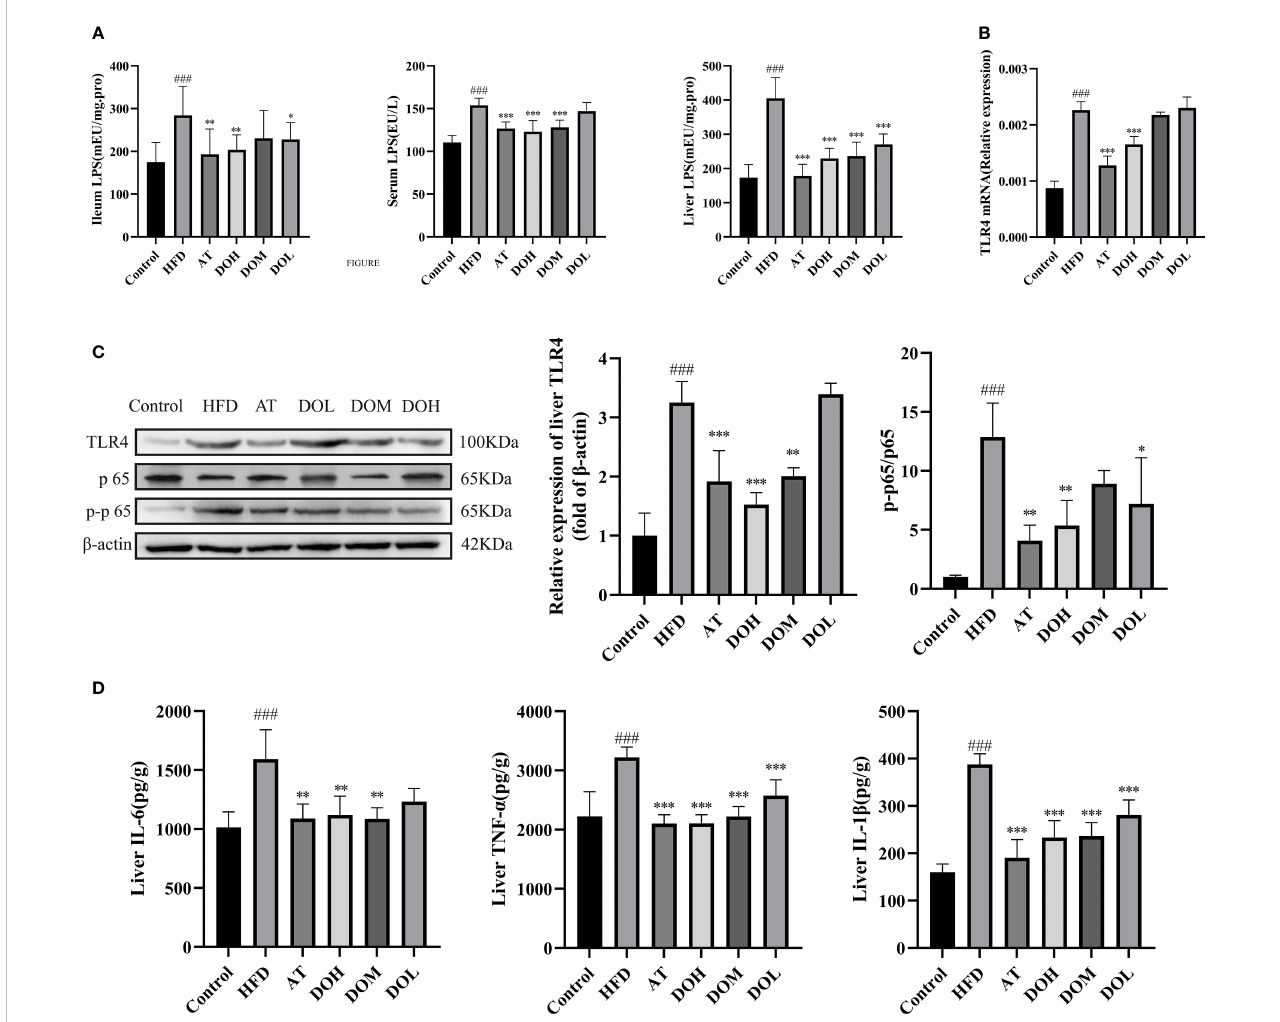
FIGURE 8 Impact of DO treatment on liver in fl ammation. (A) Ileum, serum, and liver LPS levels by group; (B) liver relative TLR4 mRNA expression by group; (C) liver TLR4 protein expression and NF- k B nuclear translocation by group; (D) liver IL-6, TNF- a , IL-1 b levels by group. A and D results are shown as the mean ± SD (n=8), and B and C results are shown as the mean ± SD (n=3). ### p < 0.001 vs. the Control group; * p < 0.05, ** p < 0.01, *** p < 0.001 vs. the HFD